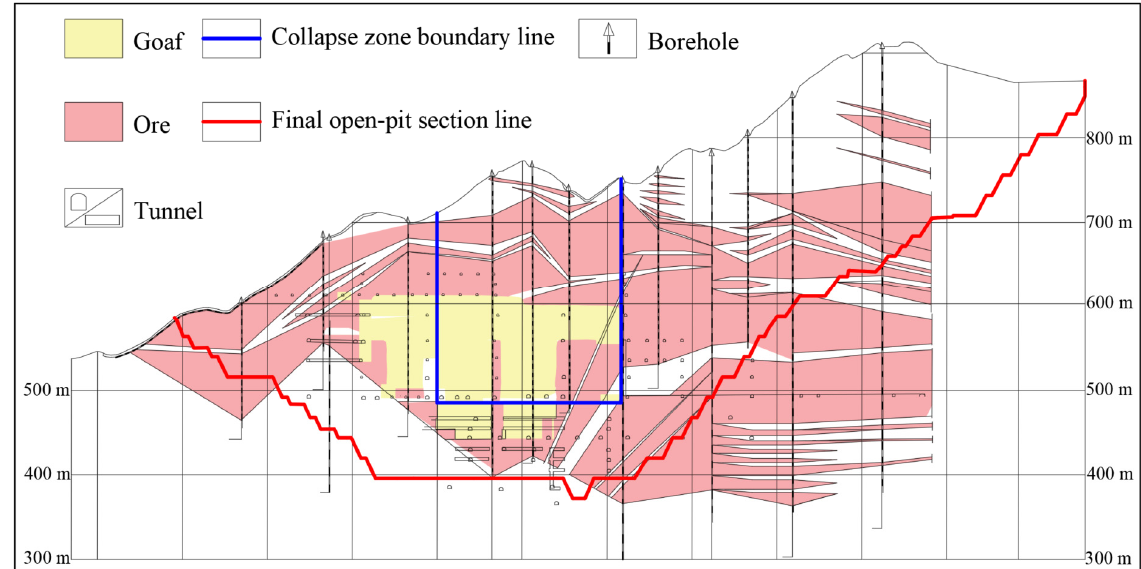
Figure 2. Cross section of the deposit.